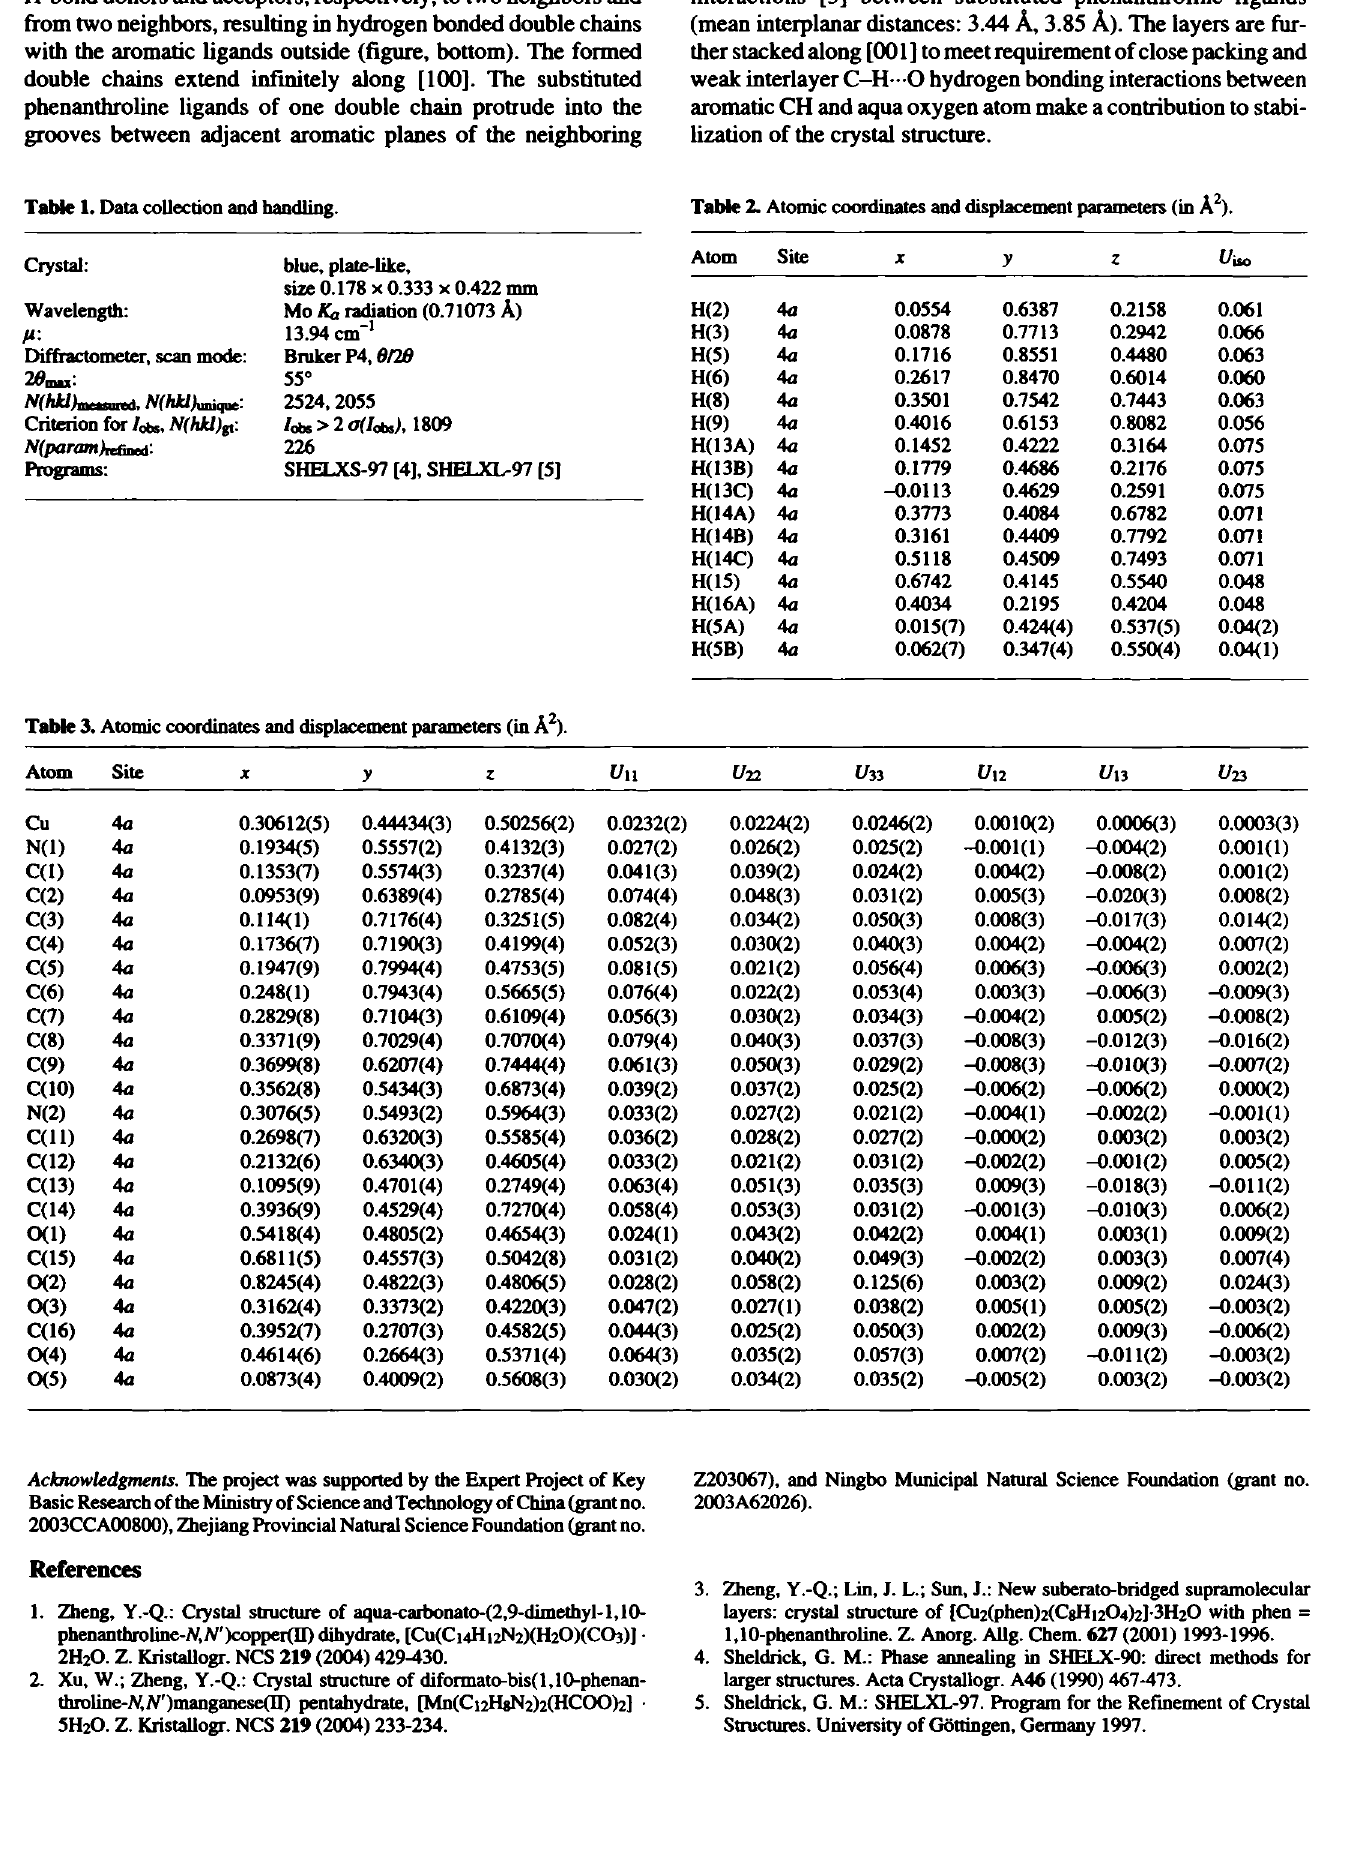
Table 3. Atomic coordinates and displacement parameters (in A 2